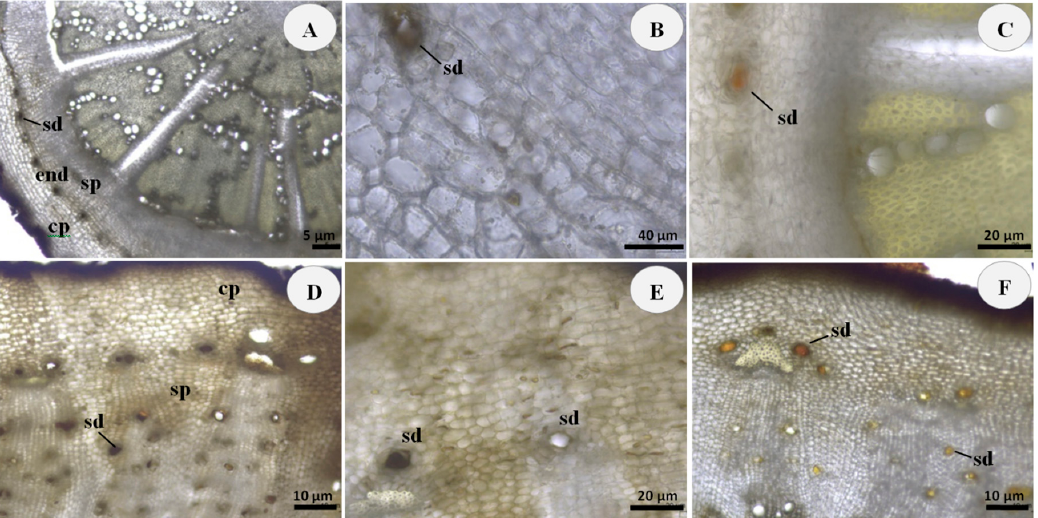
Figure 1. Root and rhizome transverse sections of wild R. carthamoides : ( A ) General aspect of unstained root section, showing the presence of secretory ducts (sd) arranged in a ring along the endoderm (end) between the cortical parenchyma (cp) and secondary phloem (sp); ( B ) Details of root secretory ducts (sd) filled with orange-brown secretion; ( C ) Secretory ducts (sd) of root stained orange-red with Sudan III for the presence of lipophilic substances; ( D ) Unstained rhizome section, showing the presence of secretory ducts (sd) located in the cortical parenchyma (cp) and the secondary phloem (sp); ( E ) Details of rhizome secretory ducts (sd) filled with orange-brown secretion; ( F ) Secretory ducts (sd) of rhizome stained orange-red with Sudan III for the presence of lipophilic substances. Scale bars: ( A ) = 5 µ m; ( B ) = 40 µ m; ( C , E ) = 20 µ m; ( D , F ) = 10 µ m.